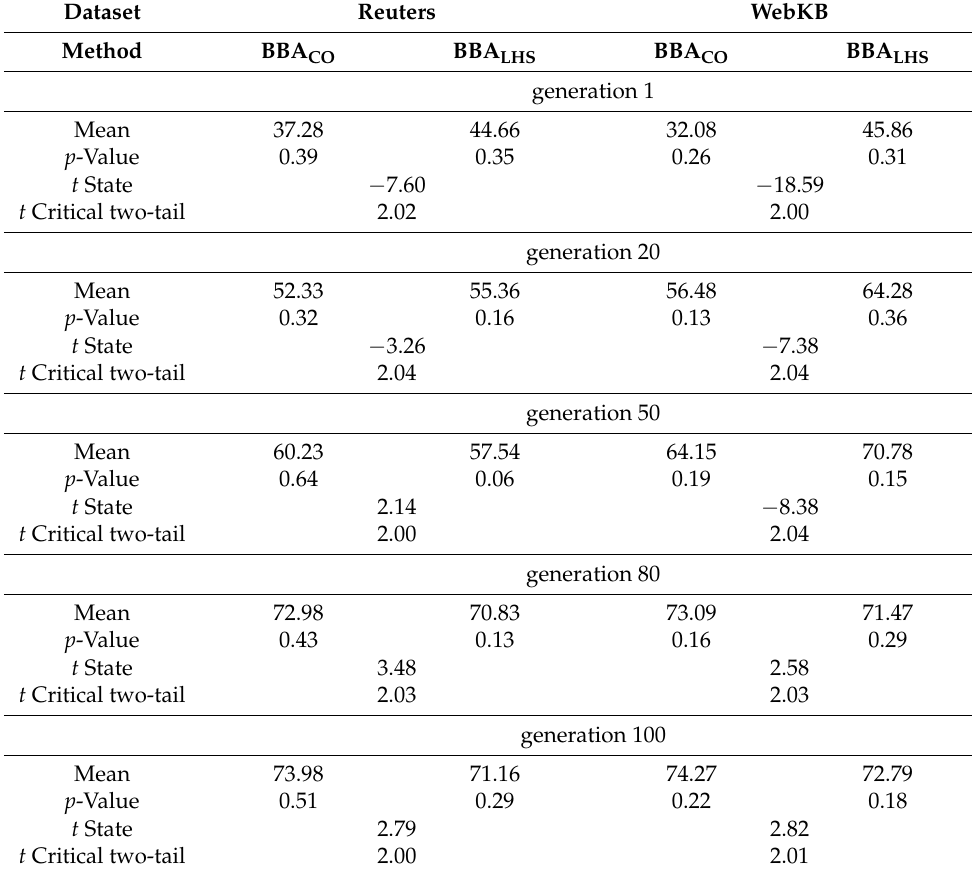
Table 4. The t -test of population quality in different generations using BBA CO and BBA LHS